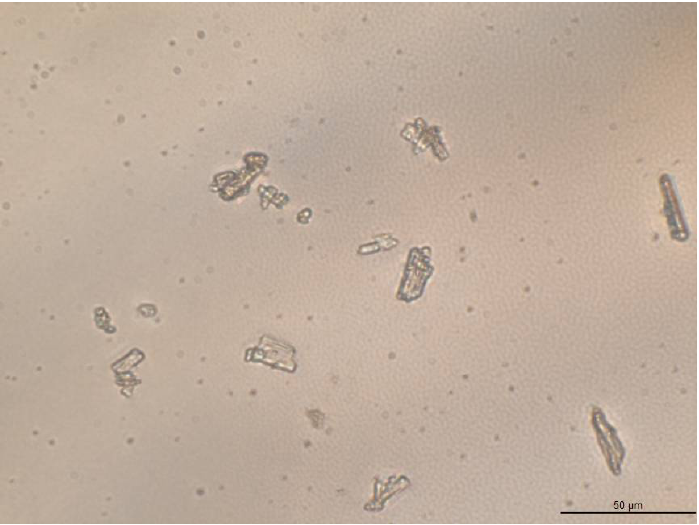
Figure 8. Optical microphotograph of posaconazole API Form I dispersed in mineral oil using transmission mode, brightfield illumination and 40× objective lens (400 magnification).